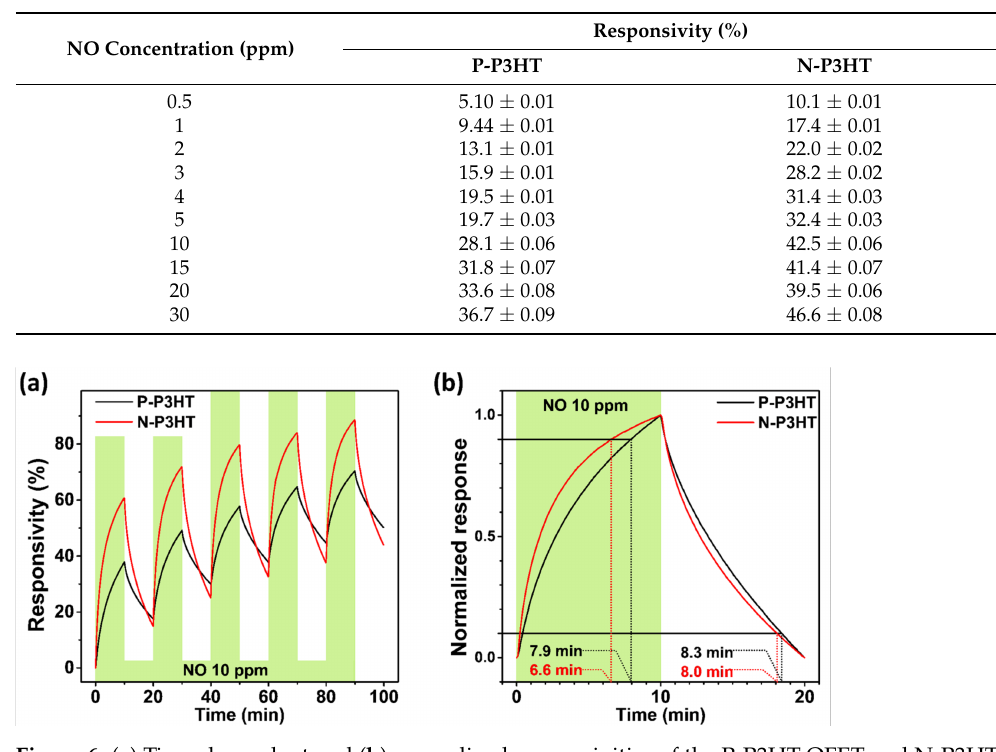
Figure 6. ( a ) Time-dependent and ( b ) normalized responsivities of the P-P3HT OFET and N-P3HT OFET